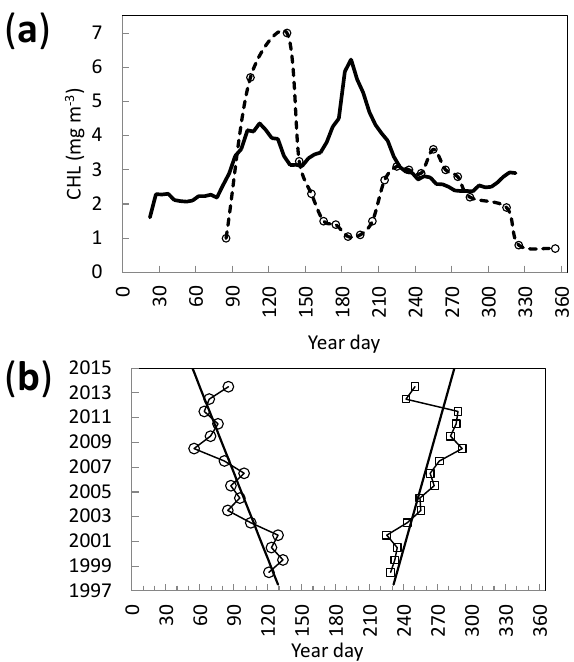
Figure 9. (a) Mean annual cycle of CHL in central Baltic Sea (area indicated in Fig. 1b) for 1997–2013 (solid line) compared with CHL measured in situ in 1985–1989 (circles, dashed line, from Kahru et al., 1991). (b) Temporal changes in the start and end of the “high chlorophyll season” (CHL> = 3mgm − 3 ) in the Baltic Sea. The connected markers and the respective regression lines are (from left to right): day when CHL = 3.0mgm − 3 is reached for the first time (DFCHL3, circles) and day when CHL = 3.0mgm − 3 is reached for the last time (DLCHL3, squares) during the